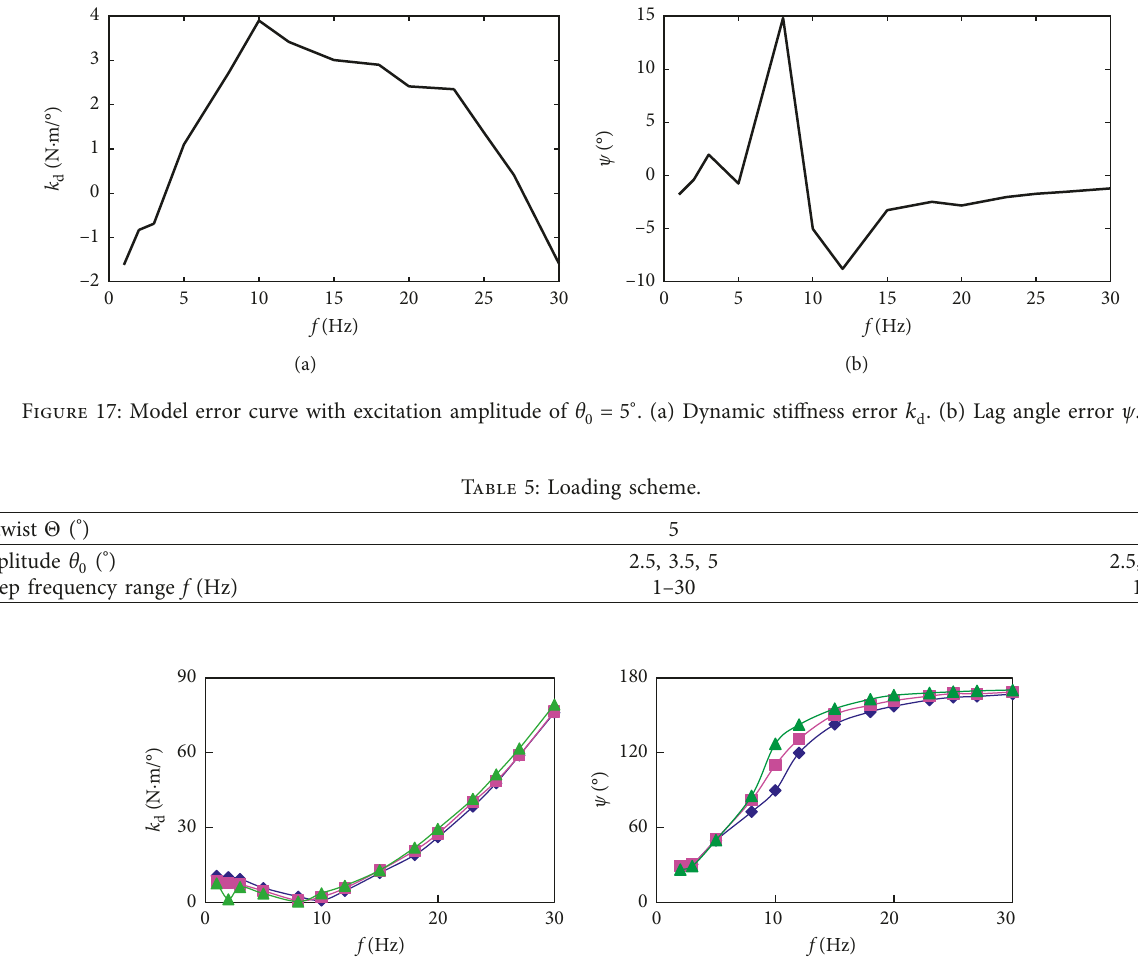
Figure 18: Different excitation amplitudes at